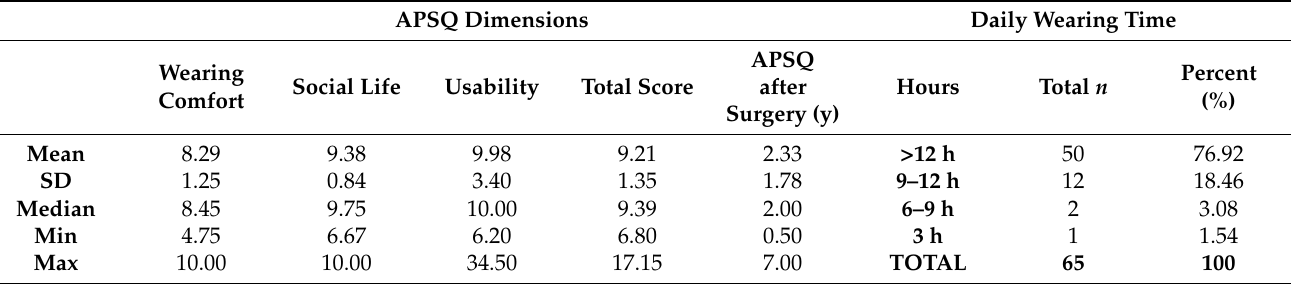
Table 2. Audio Processor Satisfaction Questionnaire (APSQ).